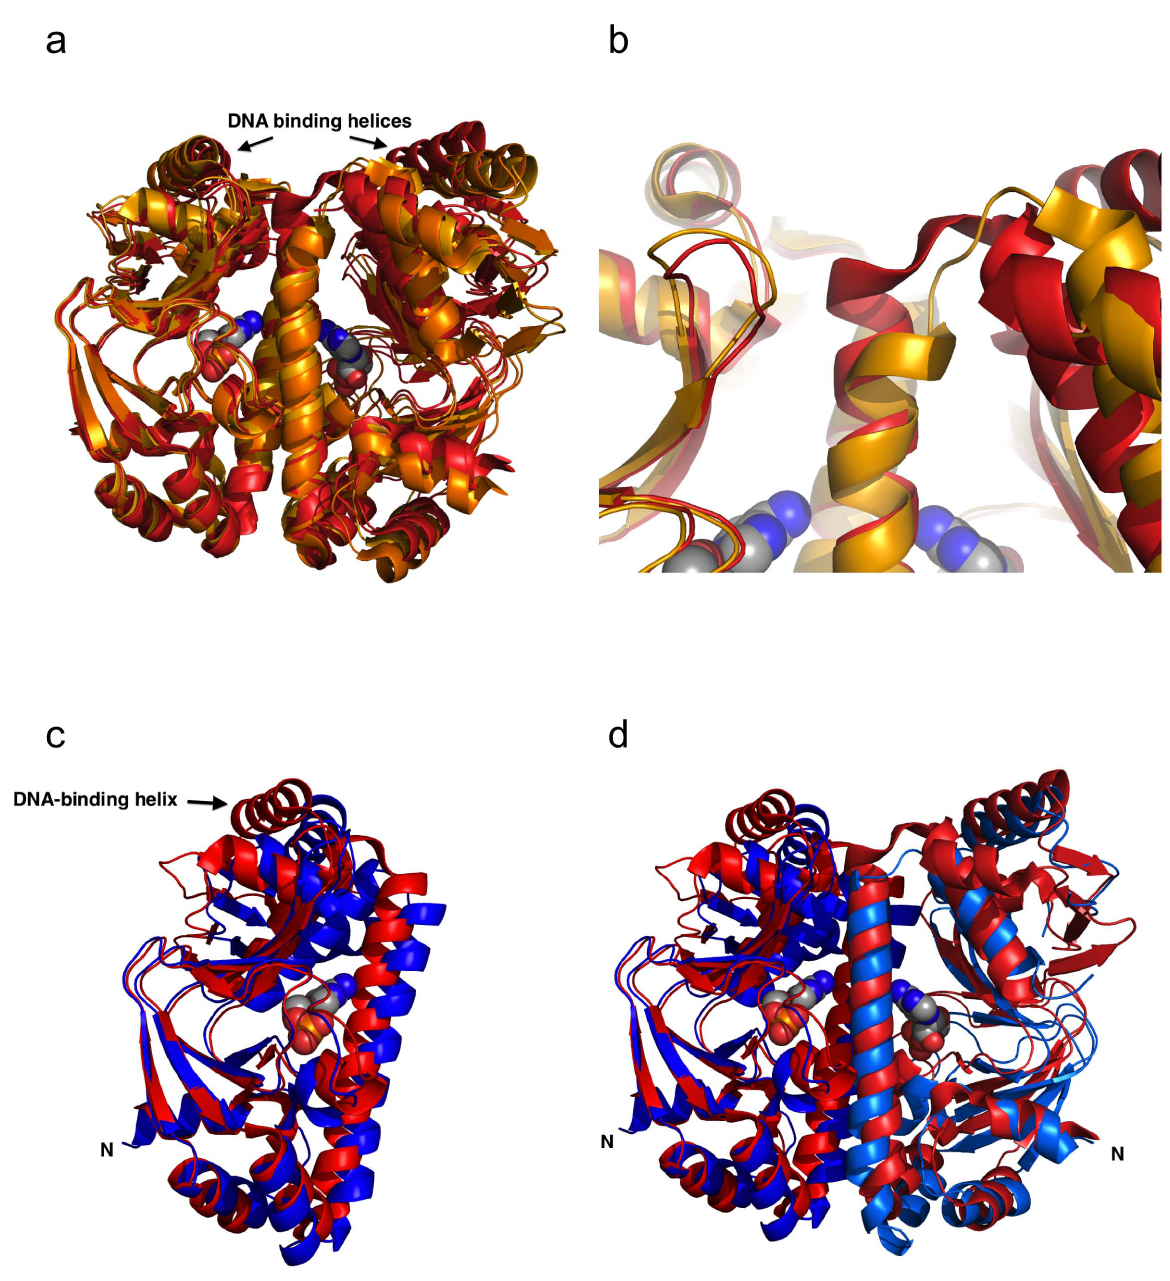
Figure 2. Comparison of Cg-GlxR crystal structures. a) Least-squares superposition of the four crystallographically independent holo Cg-GlxR dimers in crystal form II. Two distinct conformations shown in red and orange, respectively can be clearly distinguished. b) Close-up view of the holo Cg-GlxR dimers displaying the differences at the top of the dimerisation helix. The two dimers in crystal form I adopt a conformation similar to the one shown in red. c) Superposition of apo Cg-GlxR monomer (in blue) with holo Cg-GlxR (in red). View shown approximately perpendicular to the non-crystallographic 2-fold dimer axis. d) Superposition of the apo Cg-GlxR (in blue) dimer with holo Cg-GlxR (in red). In all least-squares superpositions only the ligand binding domain on the left-hand side of the picture was used to calculate the transformation matrix with COOT [42] that was then applied to the entire protein